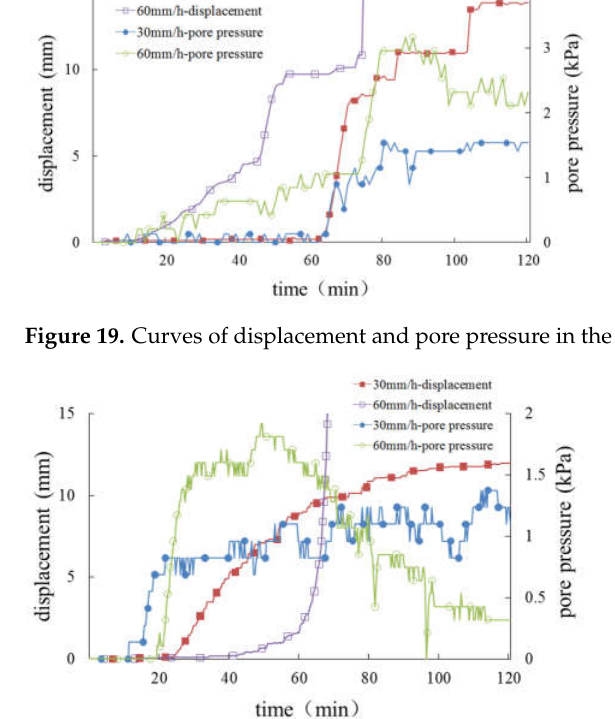
Figure 21. Curves of displacement and pore pressure in the slope without weak layer. For slopes with progressive sliding failure, the displacement and deformation curves are ladder-like, as shown in Figure 19, and the first obvious deformation displacement is defined as the start time of failure. The slope with a 20 cm-thick weak layer (Figure 19) was destroyed under two different rainfall intensities. The larger the rainfall intensity, the earlier the displacement of the slope body occurs. However, before sliding failure, the displacement of the slope surface is approximately equal. In addition, pore pressure in the slope body increases with an increase in rainfall intensity. In the slope with a 10 cm-thick weak layer (Figure 20), sliding failure occurs under the condition of rainfall intensity of 60 mm/h, while no failure occurs under the condition of 30 mm/h, and the greater the rainfall intensity, the greater the final displacement of the slope surface. For pore pressure, before the slope is destroyed, the increase in pore pressure will be faster if the rainfall intensity is strong; after the slope is destroyed, due to the adjustment of the internal struc- ture of the soil, the situation is more complex, which may form a good drainage channel, leading to a gradual decline in pore pressure with the continuation of rainfall. It can be seen from Figure 21 that the slope without a weak interlayer was not destroyed under different rainfall intensity conditions, but the larger the rainfall intensity, the larger the displacement of the slope surface, and the earlier the start time, a similar rule of pore pressure will be present in the slope body. According to the above analysis, it can be found that for the destroyed slope, when the rainfall intensity doubles, the initial deformation time of the slope is shortened by about half and the ultimate failure time is shortened by about one-third. In addition, the greater the thickness of the weak layer, the more obvious the phenomenon is; for the un- destroyed slope, when the rainfall intensity doubles, the final displacement of the slope increases by about one-third. 6.2. Relation between Weak Interlayer and Slope Deformation